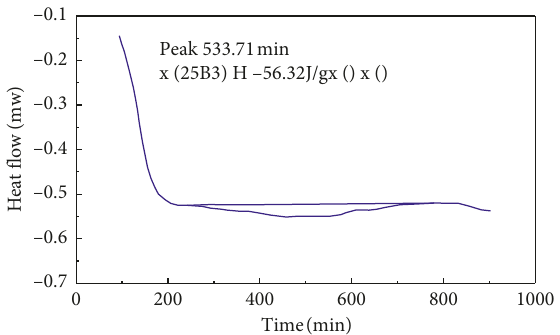
Figure 7: Cement protoplasmic DSC curve under the condition of 85 ° C.